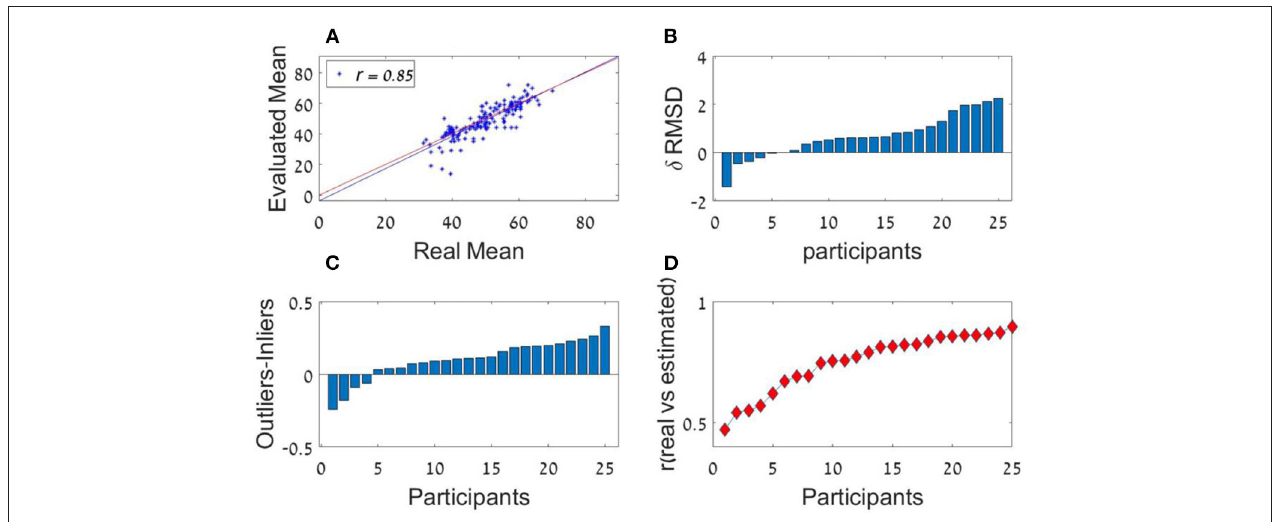
FIGURE 6 | Experiment 1a (A) Trial by trial performance of a representative individual observer. The scatter plot depicts the participant’s estimation (y-axis) for each of the presented number sequence averages (x-axis). Blue and red lines represent the regression and identity lines, respectively. (B) Individual differences in RMSD-difference ( δ RMSD) between the two sequence length conditions (positive values indicate improvement in performance as sequence length increases; Participants are sorted by RMSD-difference (from the smallest from the smallest difference to the largest). (C) Individual differences in the difference between outliers’ weight (the averaged coefficient of the first and last items in the sequence) and inliers’ weight (the averaged coefficient of all items between the second and the one before last; sorted by outlier-inlier difference, from the smallest difference to the largest). (D) Individual differences in the correlations between the estimated average and the actual average (chance corresponds to r 0). Participants in (B–D) are sorted independently. =